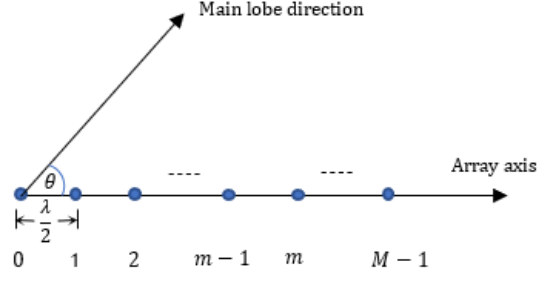
Figure 1. Symmetric linear array structure.